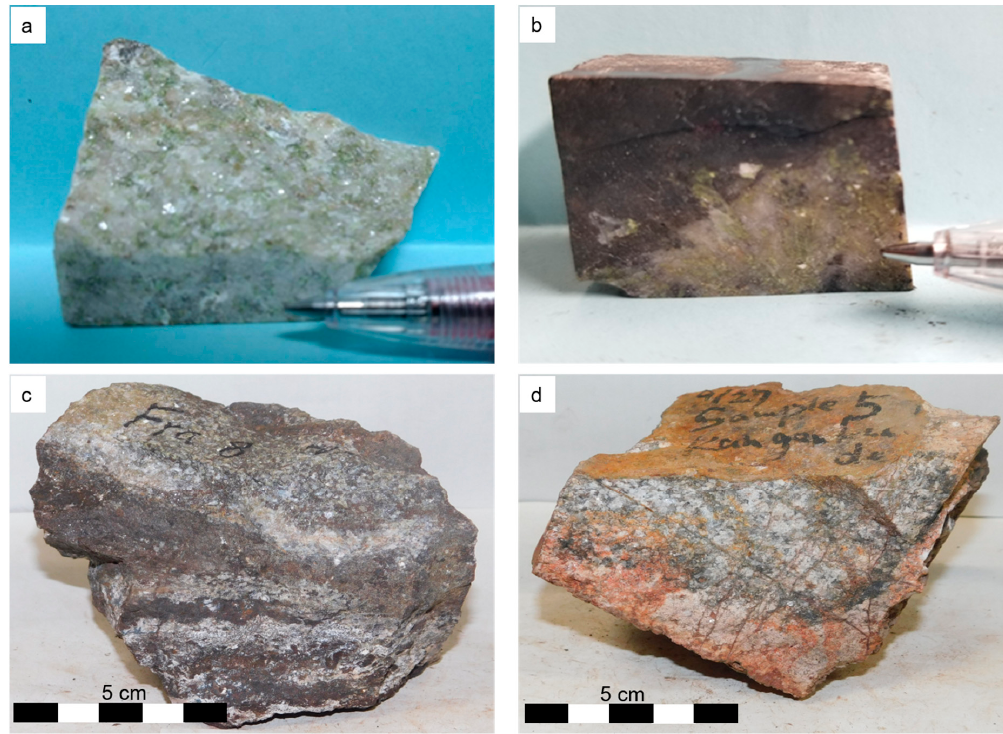
Figure 3. Photographs of representative carbonatite samples: ( a ) Light carbonatite containing polycrystalline monazite, ( b ) dark ferroan carbonatite containing well-developed monazite crystals, ( c ) apatite-rich carbonatite showing incipient mineralization, and ( d ) contact fenite.